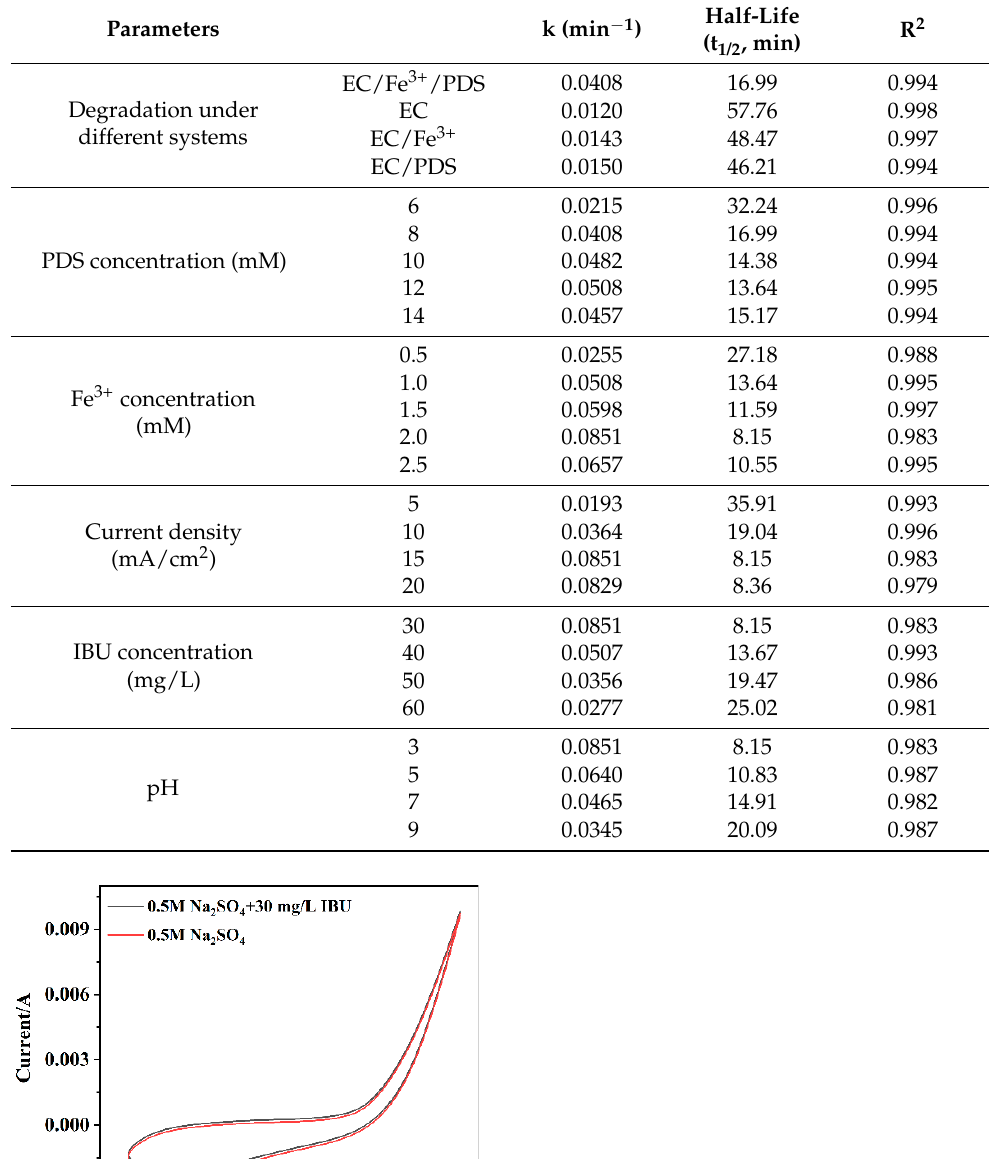
Table 1. The kinetics for IBU degradation in the EC/Fe 3+ /PDS system.